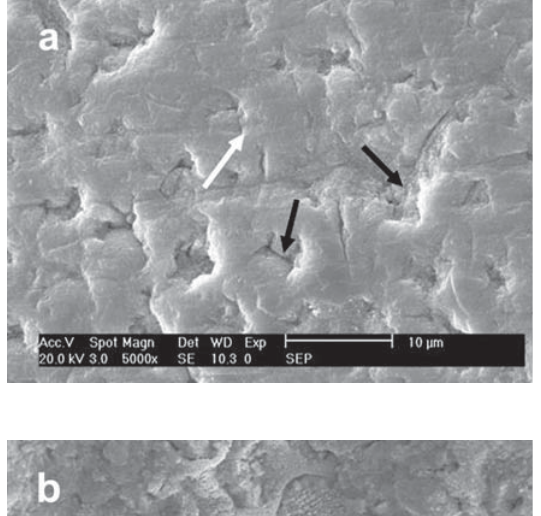
TABLE 2- Bond strength indexes (MPa; means ± standard deviations) for the tested adhesive systems regardless of